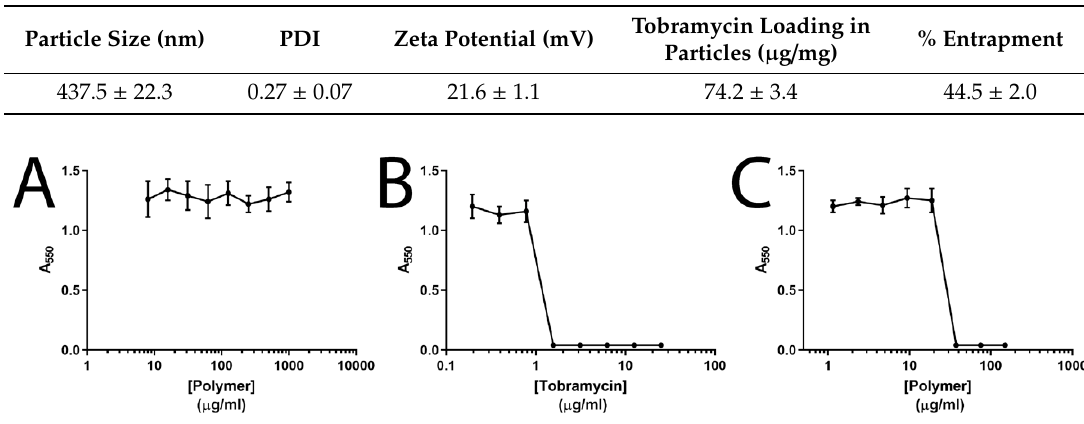
Table 2. Propertiesoftheparticlespreparedwiththeoptimalformulationofalginate:chitosan:tobramycin (9:1:1.5, w / w / w ). Results presented as mean ± S.D, N = 3.